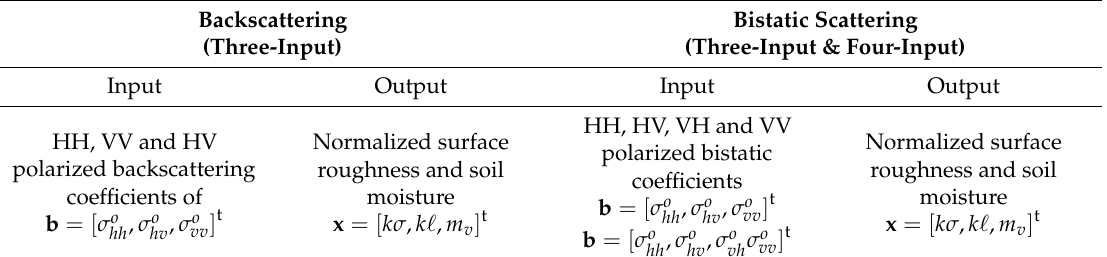
Table 1. Input–output of a dynamic learning neural network (DLNN).